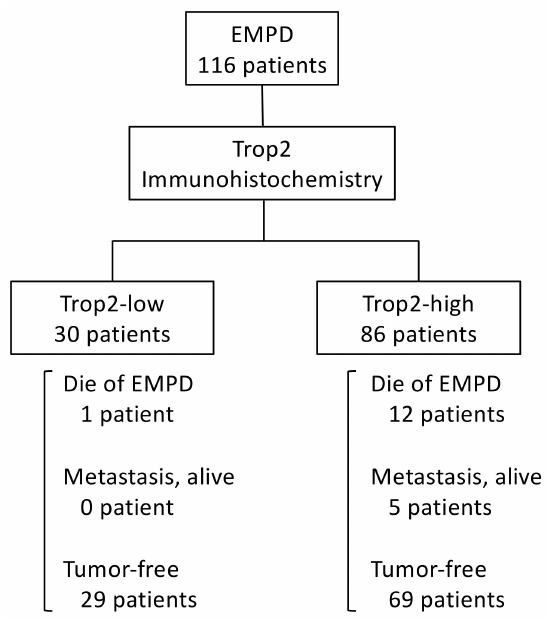
Figure 5. A schematic diagram of patients. EMPD, extramammary Paget’s disease; Trop2, trophoblast cell surface antigen